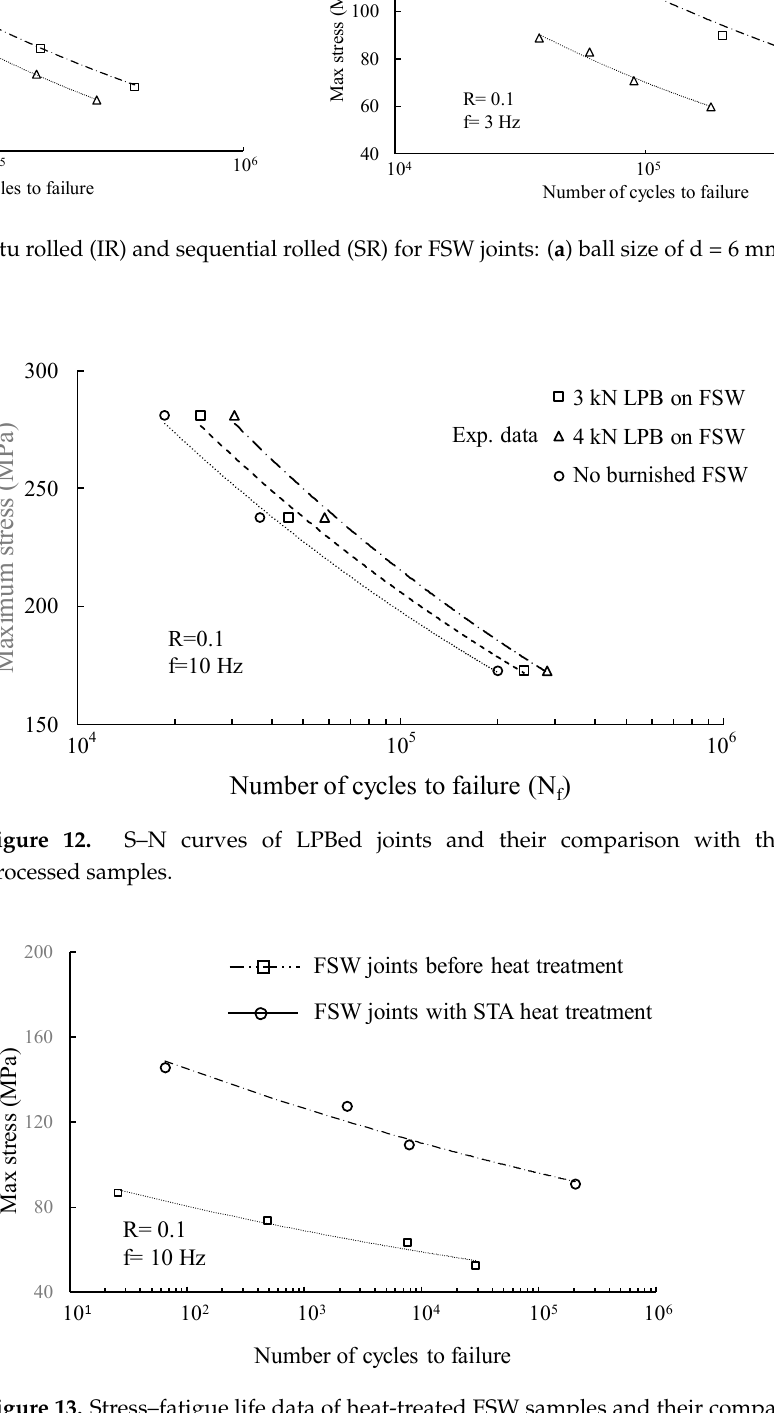
Figure 13. Stress–fatigue life data of heat-treated FSW samples and their comparison with those of as-welded joints. The STA heat treatment improved fatigue life of joints dramatically in Figure 13. The lower fatigue lives of as-welded samples could be attributed to the fact that there were no